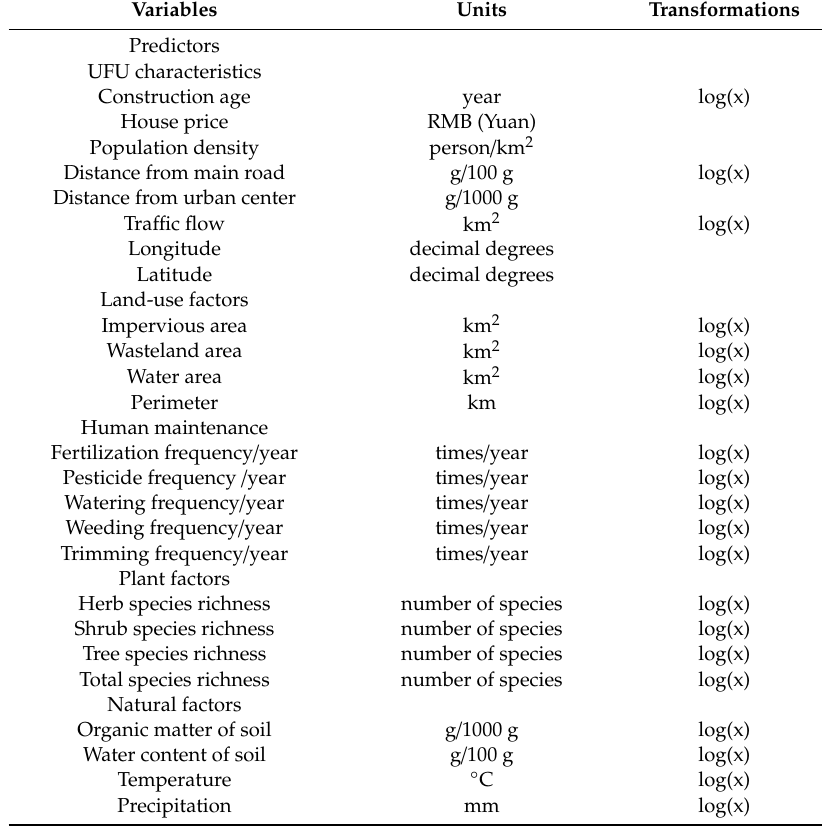
Figure 3. Areas of secondary urban functional units in Beijing, Zhanjiang, and Haikou for impervious area (km 2 ) ( a ), forest land area (km 2 ) ( b ), grassland area (km 2 ) ( c ), and water area (km 2 ) ( d ).